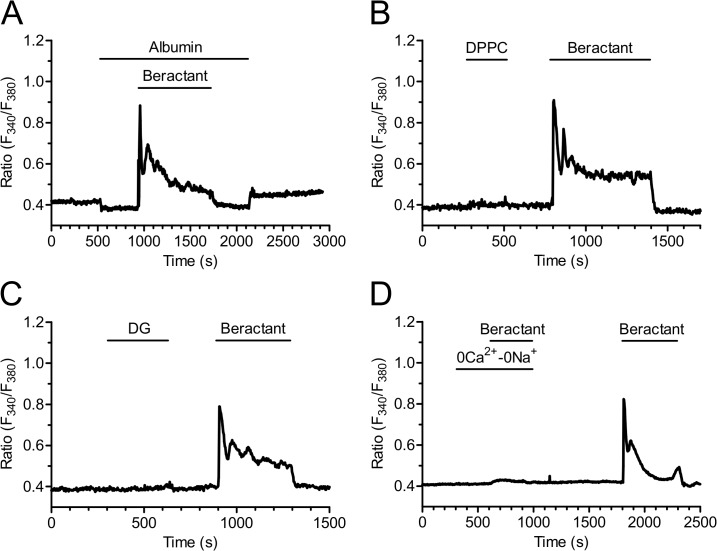
The Ca2+ response to beractant is not mimicked by albumin, (DPPC) and diacylglycerol, but is inhibited by preventing membrane depolarization.
A) Albumin, B) dipalmitoylphosphatidylcholine (DPPC) (200 μg/ml) and C) diacylglucerol (DG) (50 μg/ml) did not evoke any detectable increase in [Ca2+]i in NHLF. D) the Ca2+ response to beractant (500 μg/ml) was abrogated by replacing extracellular Na+ with an equimolar amount of NMDG in the absence of external Ca2+ (0Ca2+-0Na+).